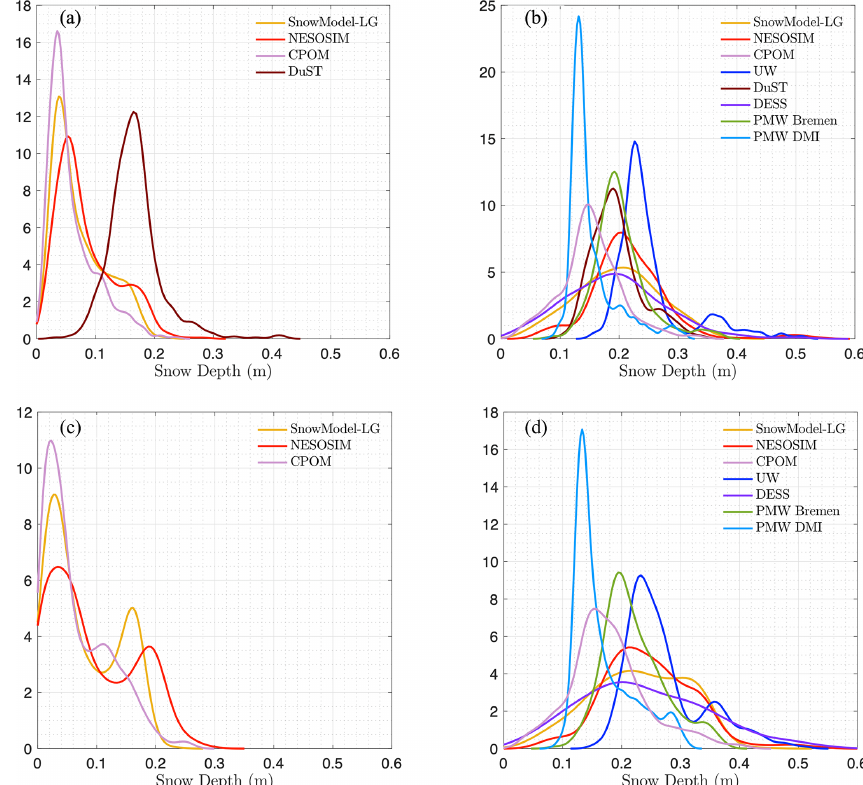
Figure 4. Snow distribution comparison within the common regions (in Fig. 1a) in all snow products during the period 2000–2018 (different products cover different periods) with/without DuST included in October–November (a, c) and March–April (b, d) .